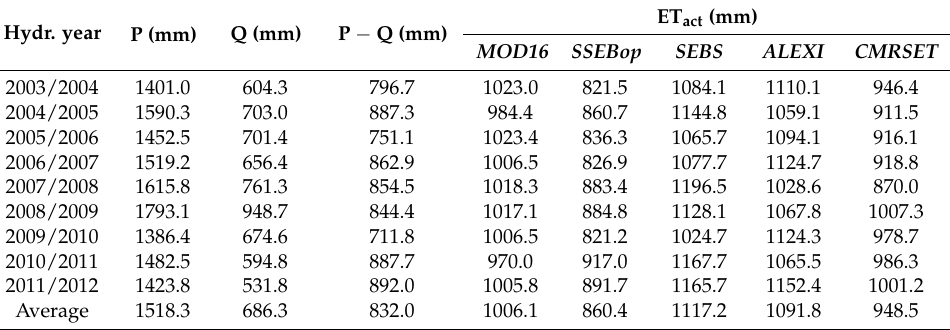
Table 4. TRMM rainfall (P), measured streamflow at Son Tay (Q) and ET act from each of the products for the overlapping period of hydrological years. Only the area upstream of the gauging station has been